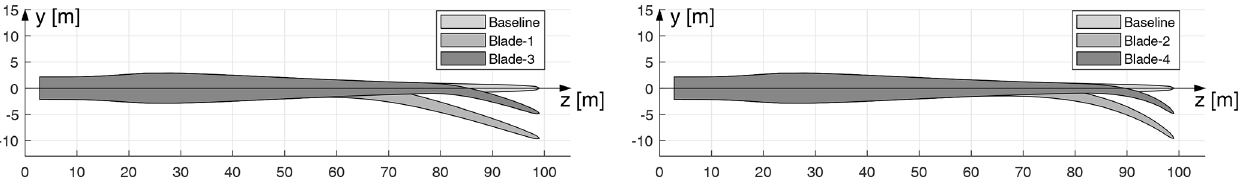
Grid (Sørensen, 1998) to create a volume grid. A total of 256 cells were used in this process, and the resulting outer domain was located at approximately 11 rotor diameters.